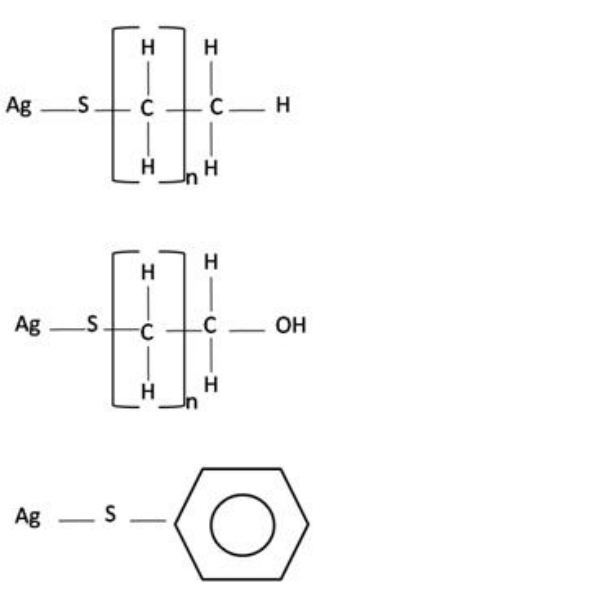
Figure 6. Schematic representation of different types of